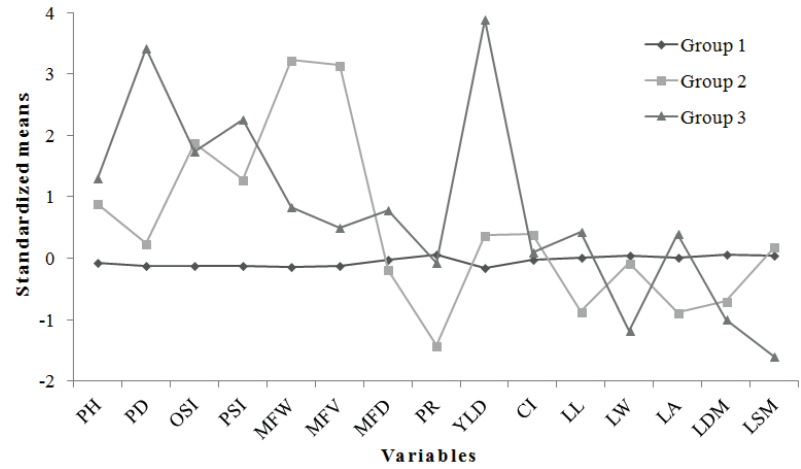
Figure 2 - Standardized means of the 15 morpho-agronomic traits for each group formed by Tocher’s optimization method. Vila Valério - ES, Brazil. Promising registered